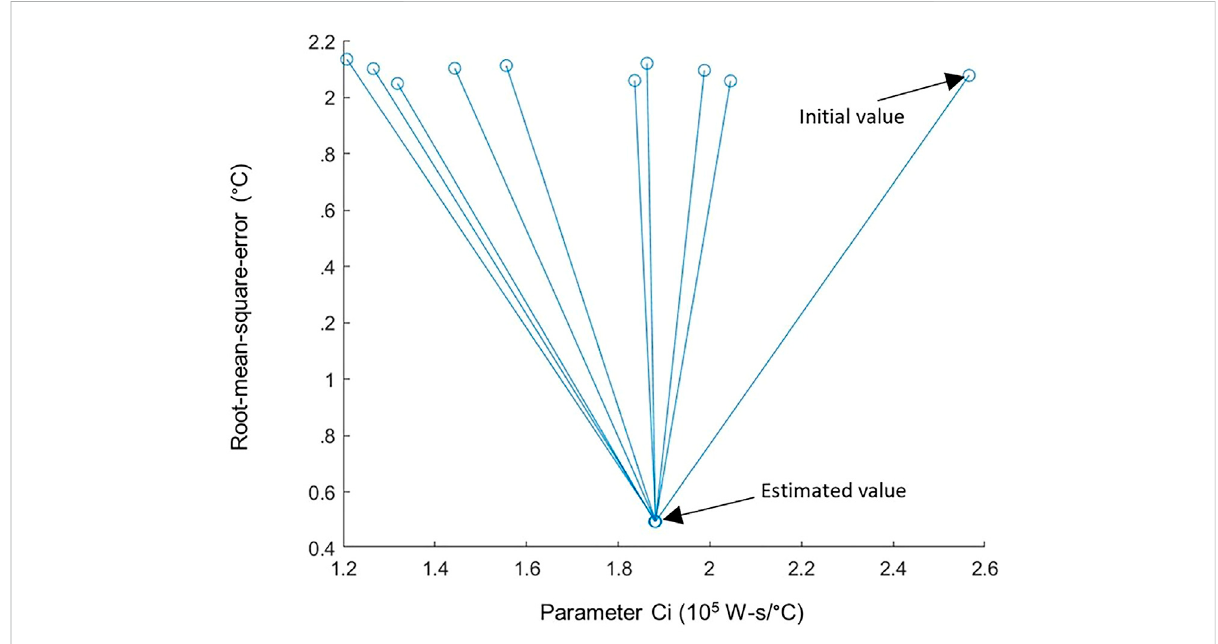
FIGURE 3 Initial vs. estimated values of parameter Ci when training with D2 in network 1R1C.